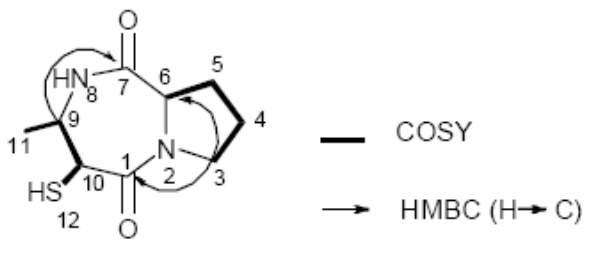
Figure 3. Key NOE correlations of compound 1